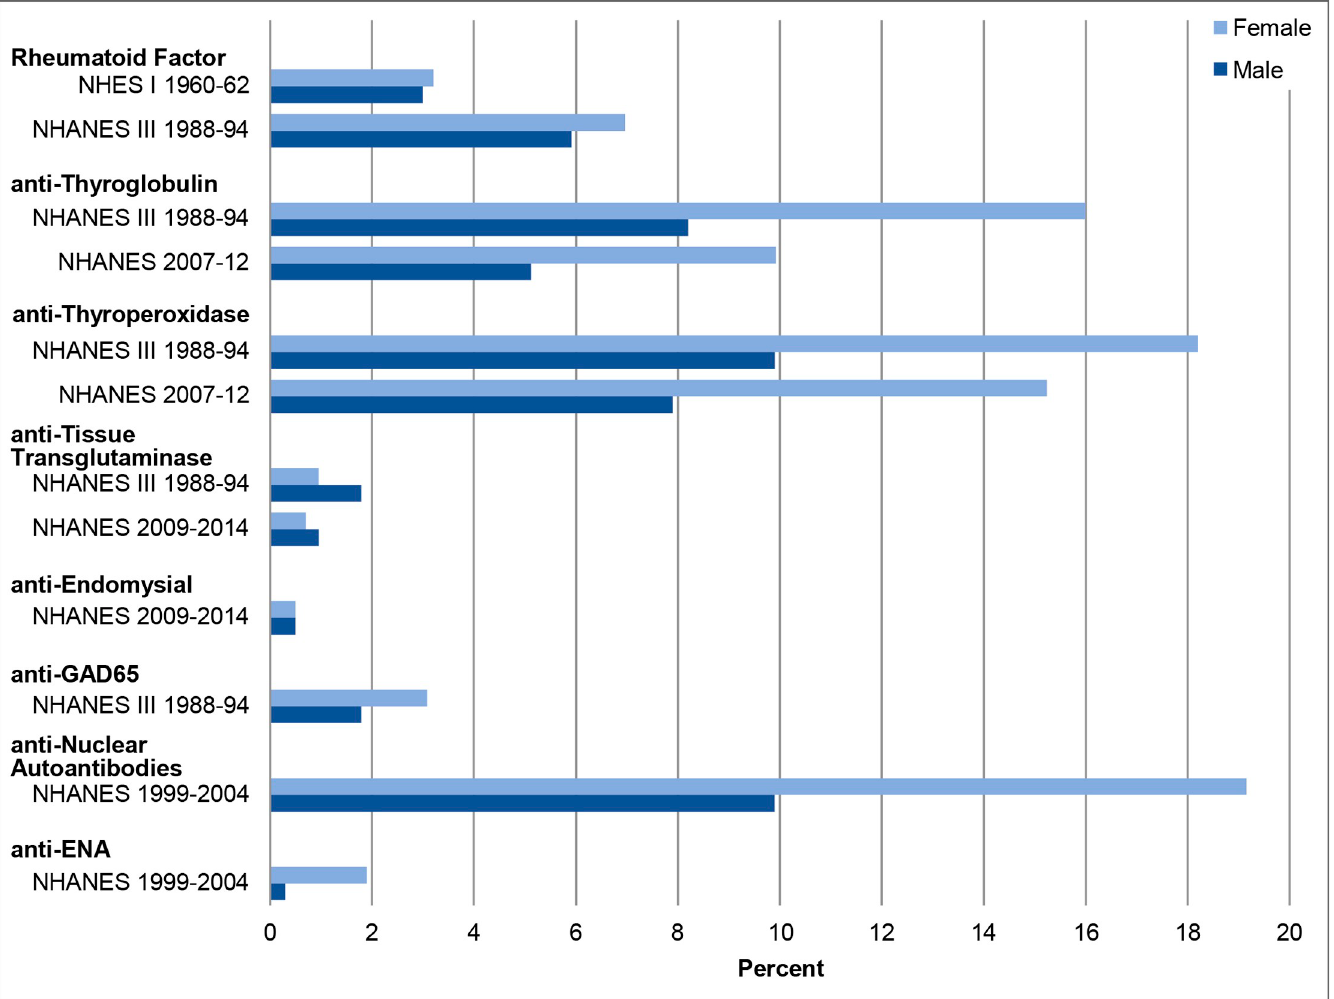
Fig 1. US prevalences of autoantibodies by sex, NHANES 1960–2014. Abbreviations: F/M Ratio = weighted female to male prevalence ratio; GAD-65 = antibodies to the 65-kDa isoform of glutamic acid decarboxylase; ENA = Extractable Nuclear Antigen.